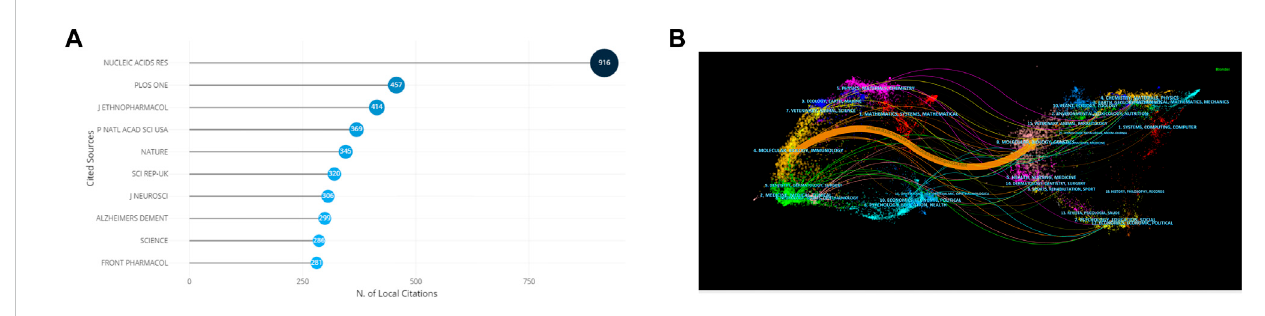
FIGURE 6 Analysis of journals and co-cited journals. (A) Top 10 co-cited journals. (B) Dual-map overlay of